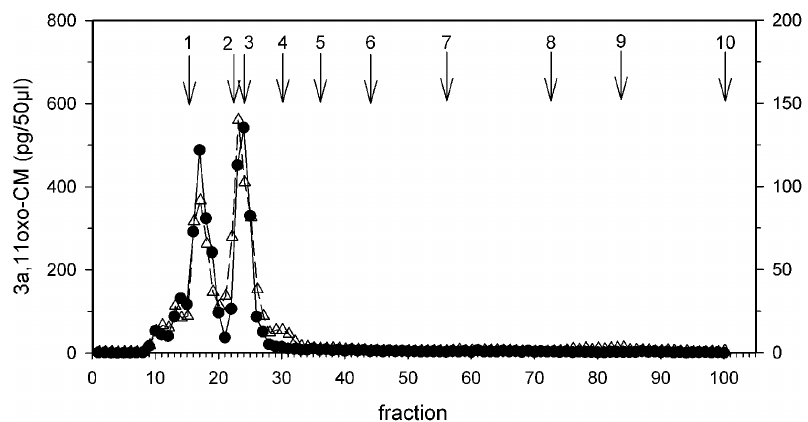
Figure 1. HPLC profiles of Eulemurcollaris . HPLC profiles of immunoreactivity detected with the 3 a ,11oxo-CM assay in a male (black circles) and female (white triangles) fecal sample extract. Arrows indicate elution positions of reference standards (1) cortisol (fraction 15), (2) corticosterone (22), (3) 11 b -hydroxyetiocholanolone (23/24), (4) 11-oxoetiocholanolone (29), (5) b andostrane-3,11,17-trione (36), (6) testosterone (44), (7) androstendione, dehydroepiandrosterone (55/56), (8) epiandrosterone, 5 b -DHT, 5 b -androstrane-3 b -ol-17-one (72), (9) 5 b -androstrane-3 a -ol-17-one (82/83), (10) androsterone (100).